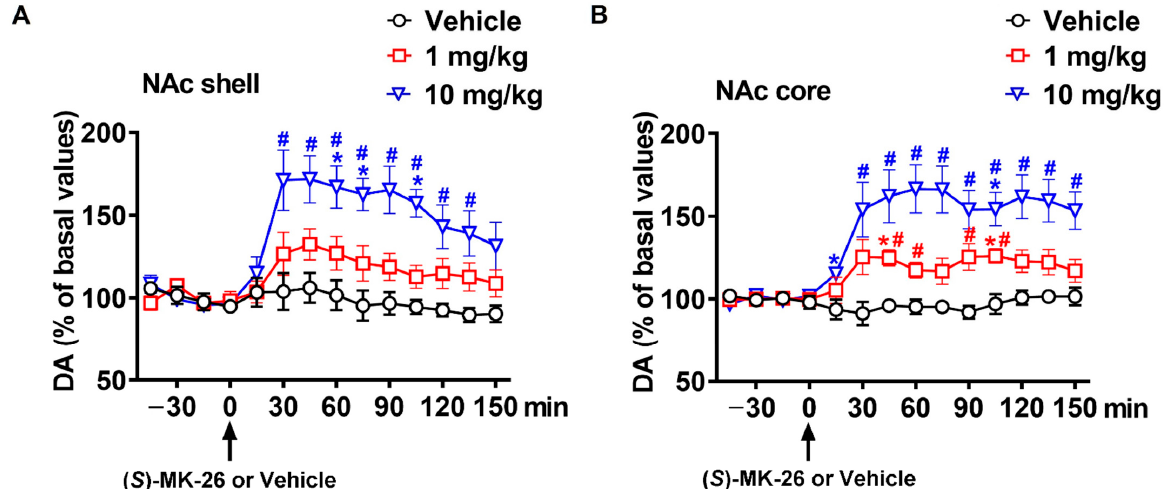
Figure 5. Extracellular dopamine concentrations in the accumbal shell ( A ) and core ( B ) dialysates obtained from SD male rats treated with ( S )-MK-26 (1, 10 mg/kg) or vehicle (Kolliphor EL 30%). Rats stereotaxically implanted with a microdialysis probe aimed at the accumbal shell or core were placed individually into the experimental cage and perfused with dialysis buffer. During the experiment, four initial dialysate aliquots were collected, one every 15 min, before intraperitoneal administration (indicated by arrows) of either the vehicle (Kolliphor EL 30% 1.5 mL/kg) or ( S )-MK-26 (1 or 10 mg/kg) and collection of subsequent 10 dialysate aliquots for dopamine determination commenced. Values are percentages (with 100% as the average of the last four dopamine basal values before treatment) and expressed as means ± SEM of the values obtained by 3–5 rats per group. *: p < 0.05 with respect to basal values (before treatment); #: p < 0.05 with respect to vehicle-treated rats (two-way ANOVA for repeated measures followed by Tukey’s multicomparison test). Basal dopamine levels in NAc were 6.53 pg (in shell) and 7.29 pg (in core) per 20 µL of dialysate, corresponding to extracellular dopamine concentrations of approximately 2.13 nM and 2.38 nM, in shell and core, respectively.